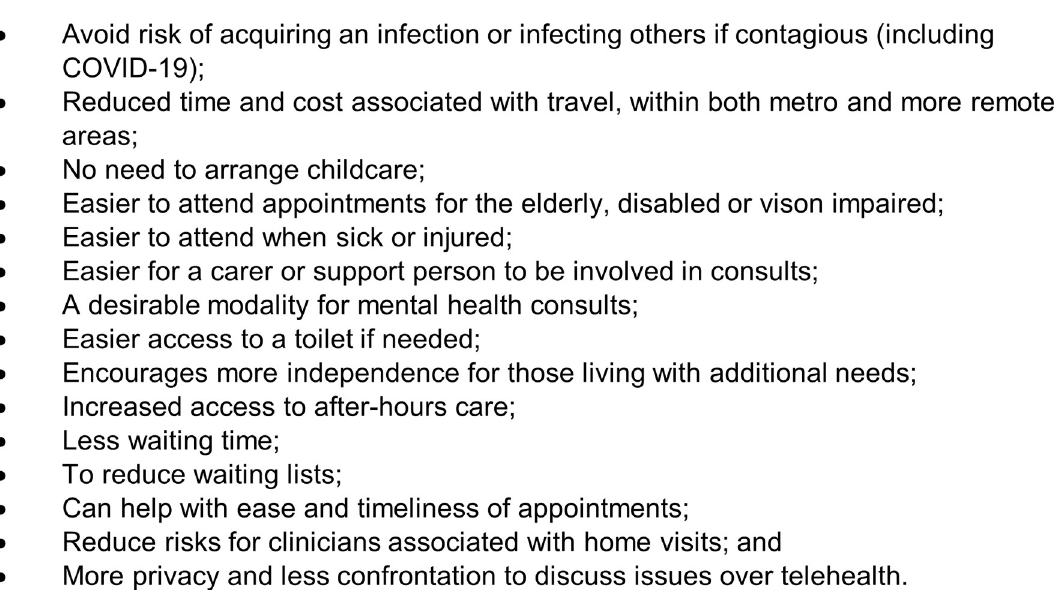
Fig 2. Participant views on convenience and risk reduction associated with telehealth